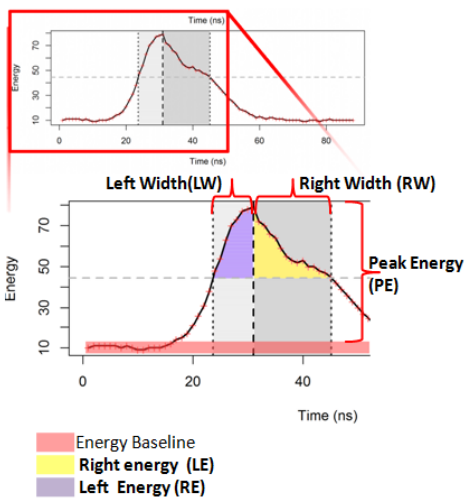
Figure 2. Plot of energy digitizer values over time for a return FW signal: characterization of waveform by amplitude (PE) and partial integral of parts including two